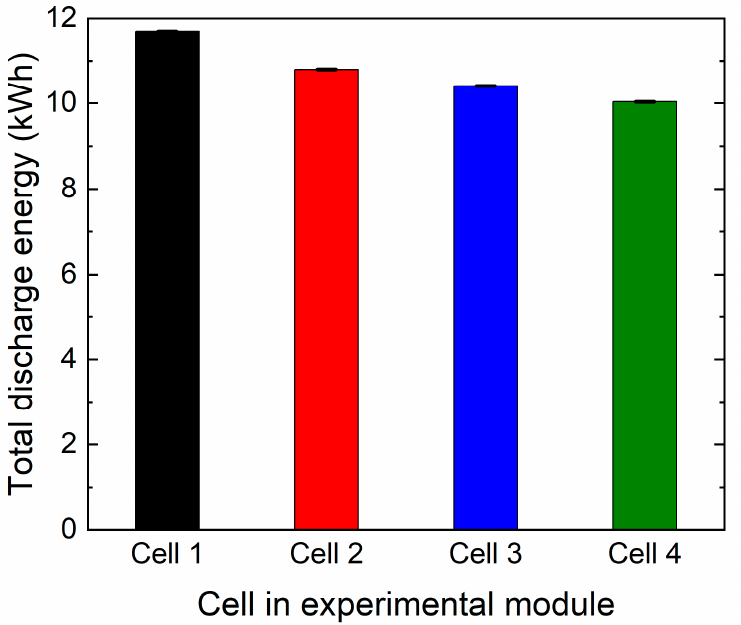
Figure 10. The total discharge energy in 1400 cycles for each cell in the parallel ‐ connected module. Cell C1 discharges at 30 °C and other cells at 20 °C. A 0.02% error bar is considered in the analysis.